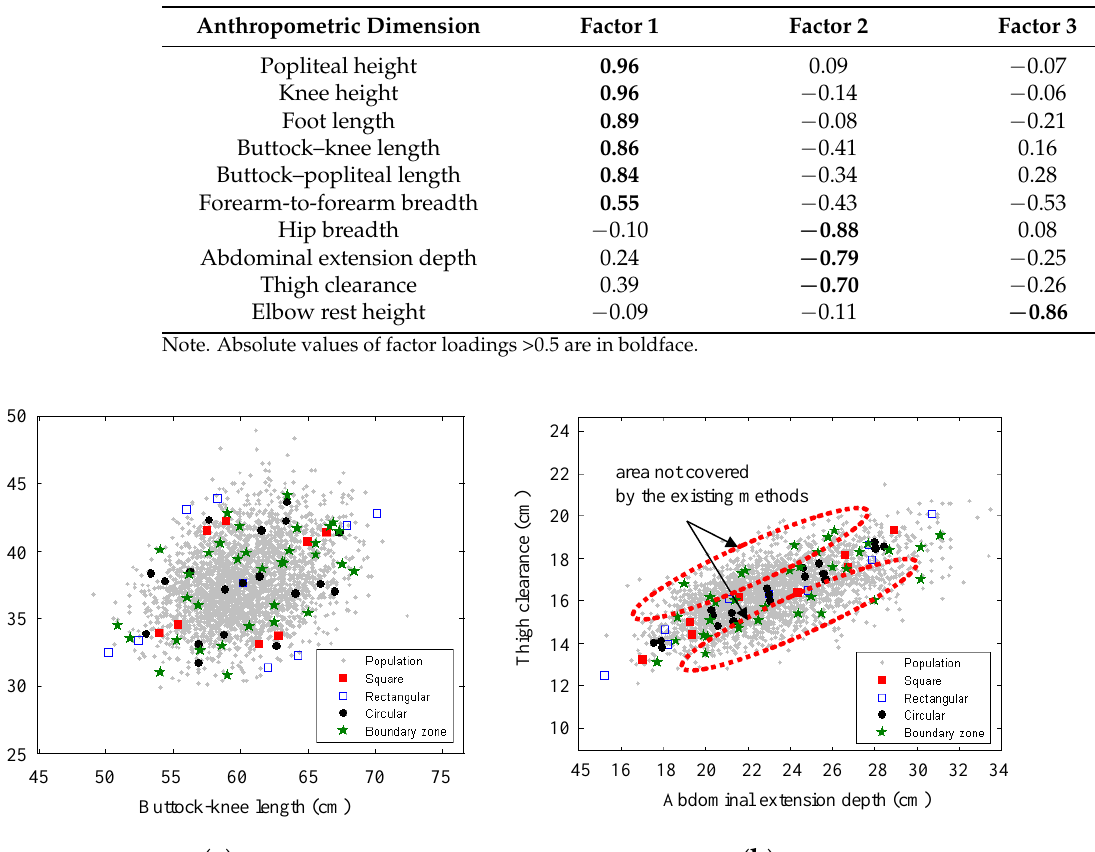
Table 3. Factor loadings of anthropometric dimensions.